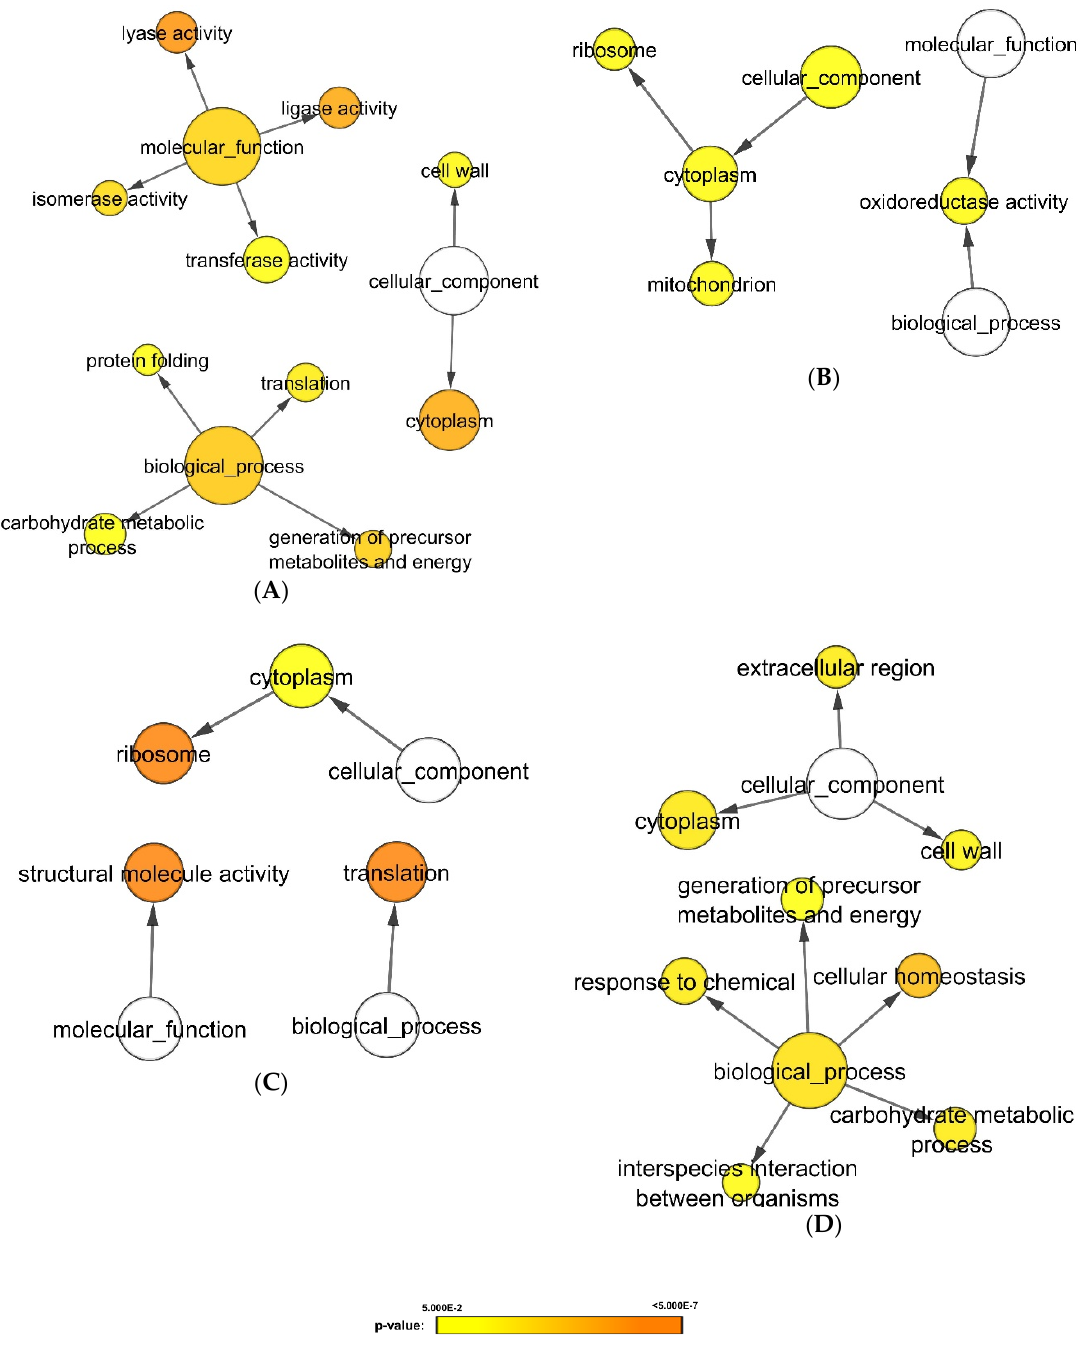
Figure 6. Gene ontology analysis of proteins with lower expression in C. albicans biofilms when exposed to di ff erent groups of bacteria. Proteins extracted from 48 h mature biofilms were sent for label free mass spectrometry analysis. Di ff erential expression analysis was first applied to determine biofilms’ proteins which were lower in each cluster. Subsequent gene ontology analysis illustrated biological processes which were significant lower in the C. albicans under bacterial stimulants: ( A ) Group 1: A. naeslundii , E. faecalis , and P. gingivalis ; ( B ) group 2: A. actinomycetemcomitans and F. nucleatum ; ( C ) group 3: S. mutans and S. sanguinis ; ( D ) group 4: S. mitis and S. sobrinus ( p -value < 0.05). The protein expression levels were represented in p -value using di ff erent colors: yellow (least significant) to orange (most significant). The white circles describe the 3 distinct aspects of how gene functions can be described: molecular function, cellular component, and biological process.